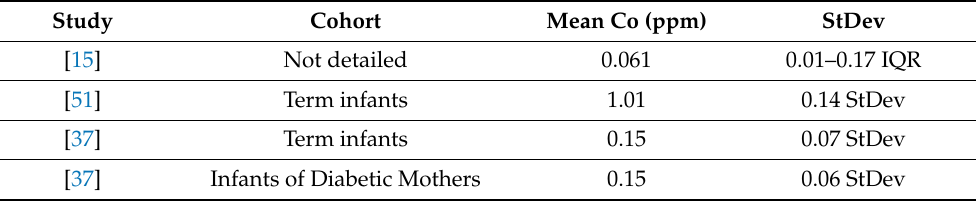
Table 7. Cobalt in